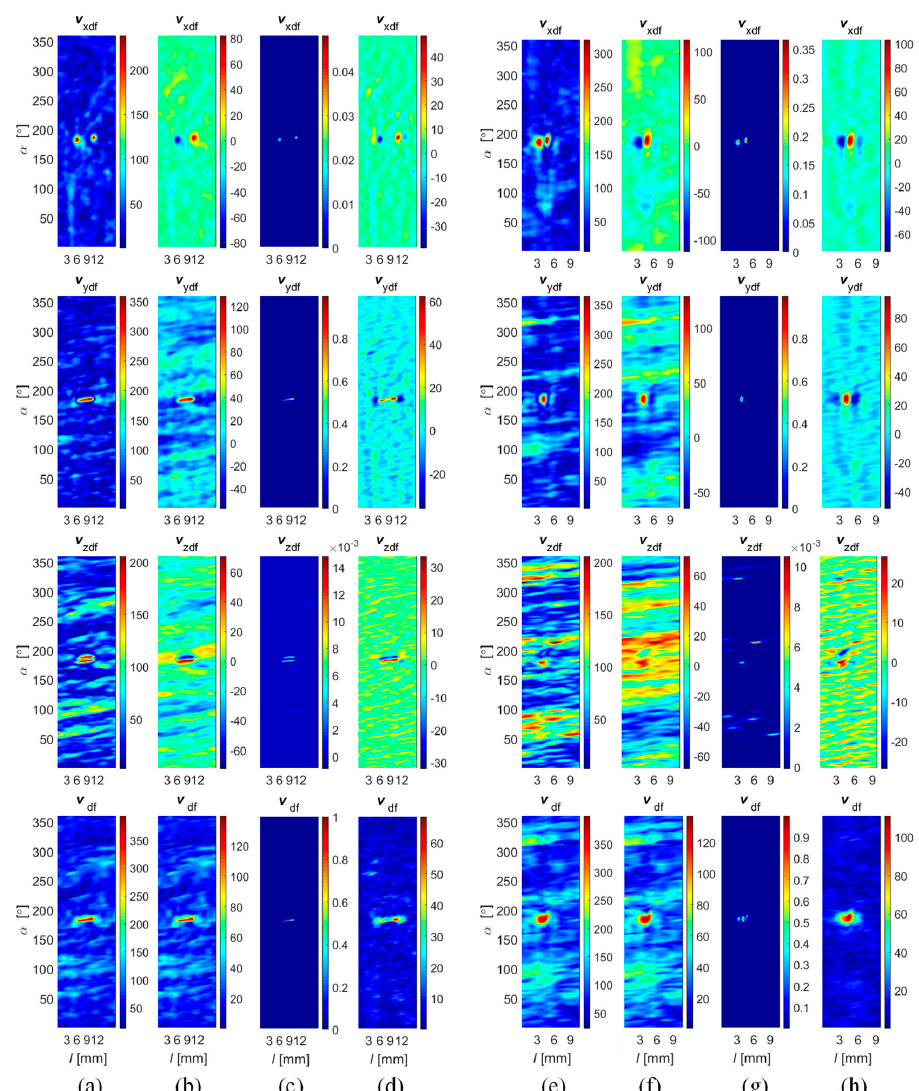
Figure 14. Results of Stages I ( v xdf , v y df and v zdf ) and II ( v ndf ) of data fusion obtained for axial defect d 5 with 2 mm depth using ( a ) DF vec ; ( b ) DF SF ; ( c ) DF IOP ; and ( d ) DF PYR algorithms; and for a circumferential defect d 4 with 0.5 mm depth using ( e ) DF vec ; ( f ) DF SF ; ( g ) DF IOP ; and ( h ) DF PYR algorithms.